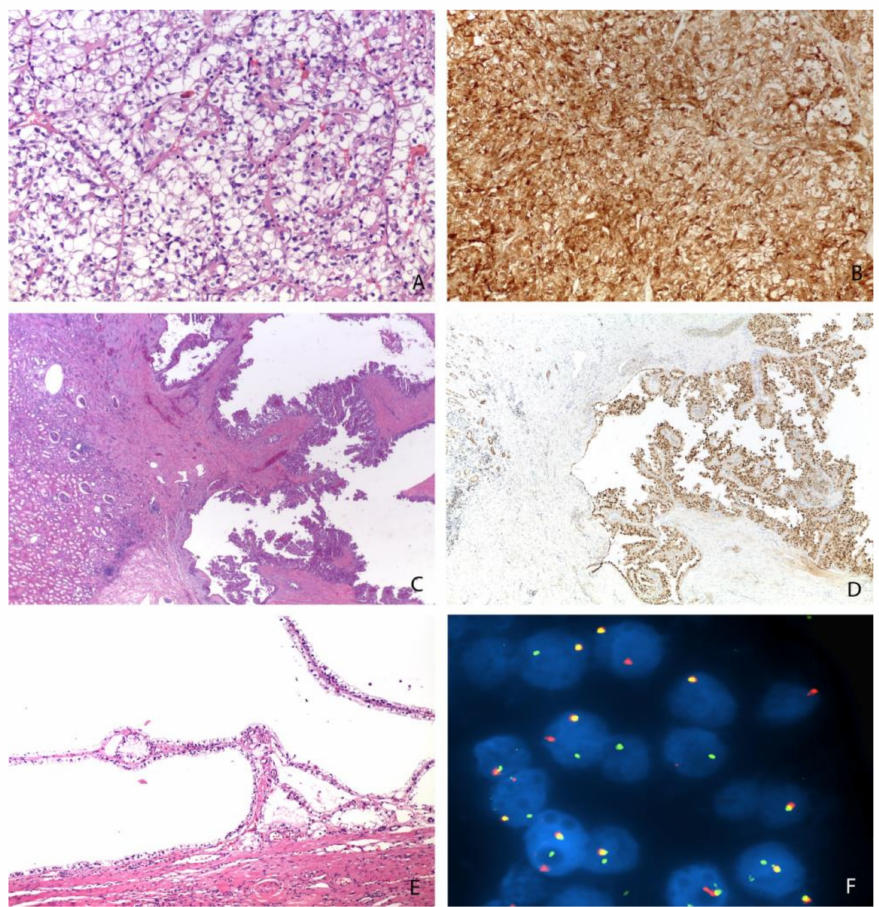
Figure 2. Di ff erent morphologies of Xp11 translocation renal cell carcinomas: resembling a clear cell renal cell carcinoma (Magnification: 200 × ) ( A ), showing a papillary (Magnification: 25 × ) ( C ) or cystic (Magnification: 100 × ) ( E ) pattern. An example of strong and di ff use expression of cathepsin K (Magnification: 200 × )( B ),thenuclearpositivityofPAX8(Magnification: 25 × )( D ),andthedemonstration of TFE3 gene rearrangement by FISH (Magnification: 1000 × ) ( F